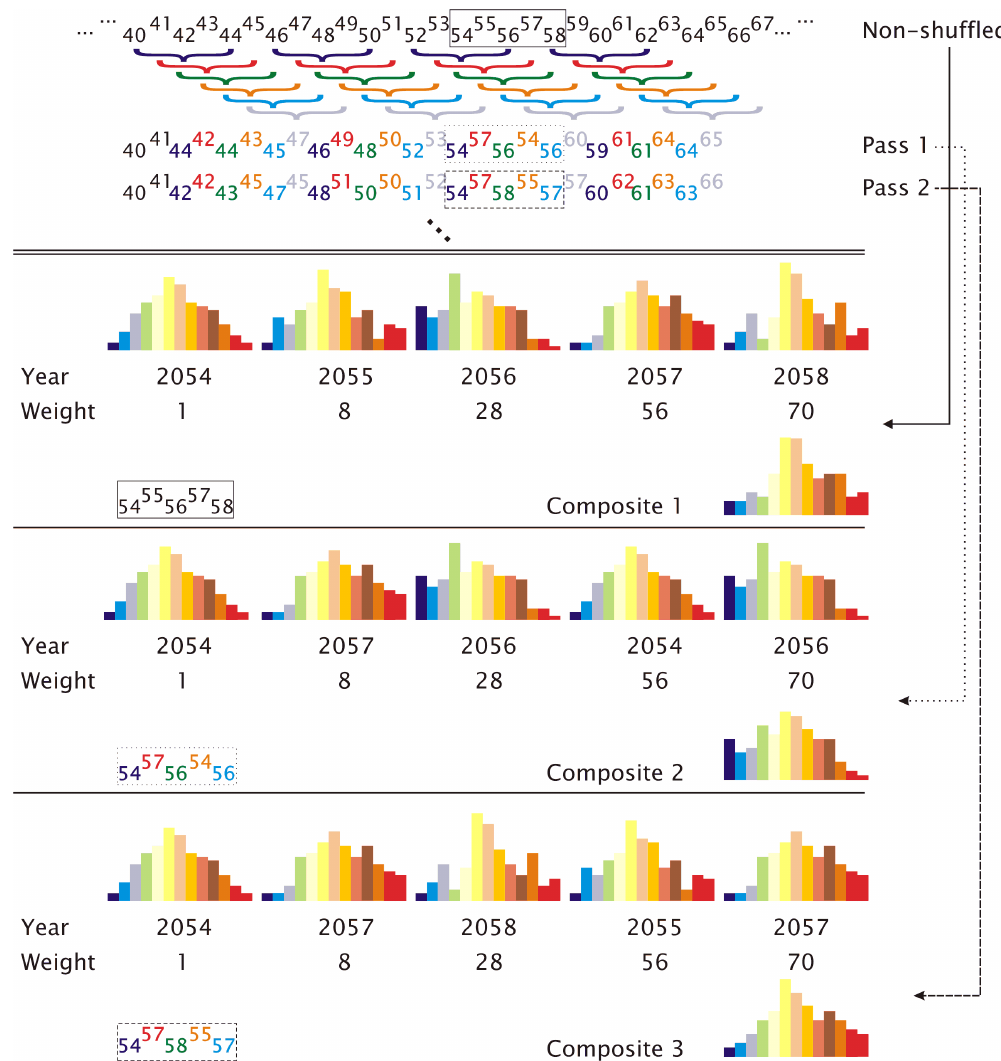
Figure 7. Sketch of the resampling of years that contribute to a time window (explained in